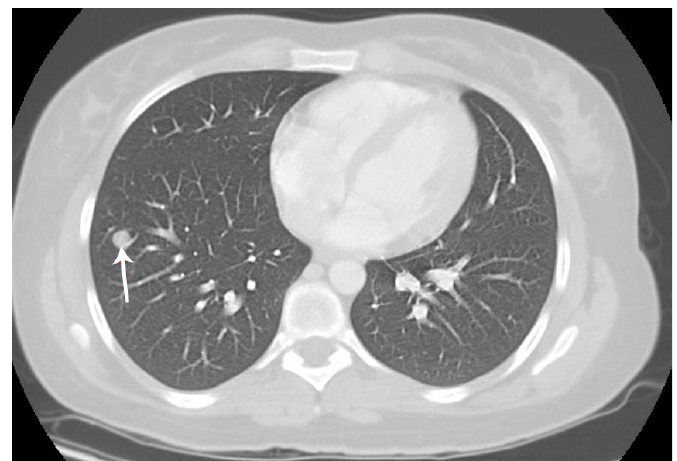
Figure 1. Computed tomography of the abdomen and pelvis with intravenous contrast showing free fluid in the pelvis and active peri-uterine contrast extravasation (arrows) concerning for neoplastic process eroding into the uterine vasculature.